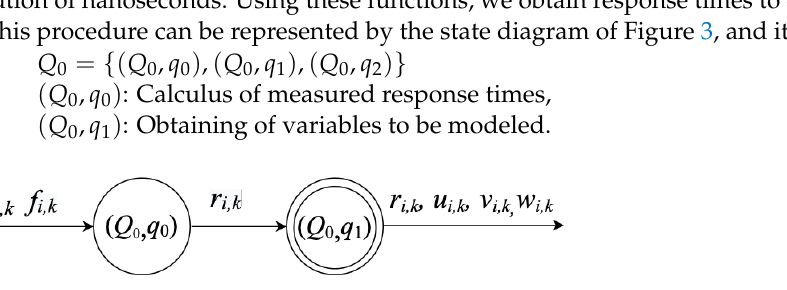
Figure 3. States diagram Q 0 for experimental measurement of response times dynamic.